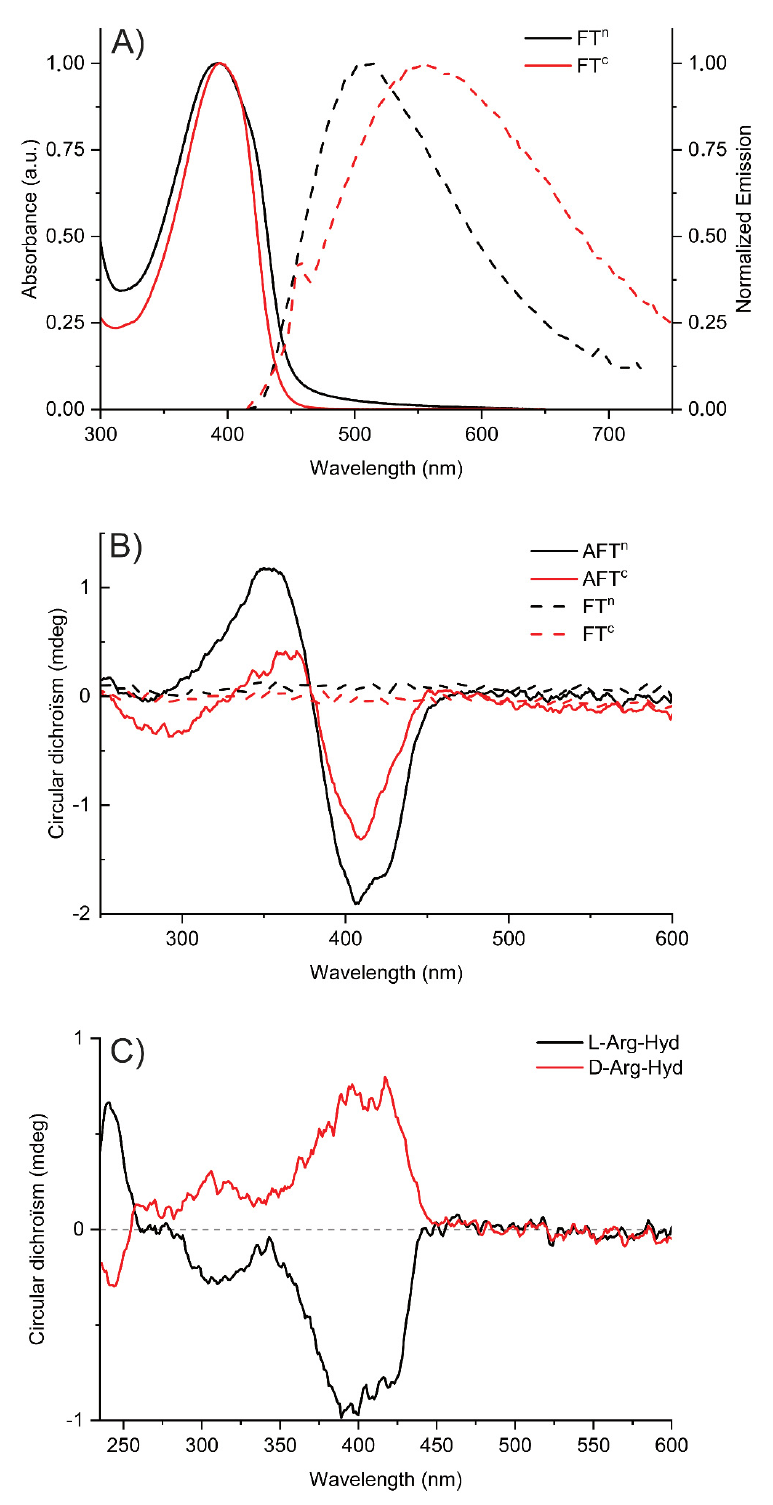
Figure 3. Spectroscopic analysis for 10 µ M aqueous solutions in TE buffer (pH 7.4). ( A ) Normalized UV-Vis absorption spectra (plain curves) and emission spectra (dashed curves) of FT c and FT n in TE buffer. ( B ) CD spectra of FT c , FT n , AFT c and AFT n . ( C ) CD spectra of L -Arg-Hyd and D -Arg-Hyd conjugates of FT n .